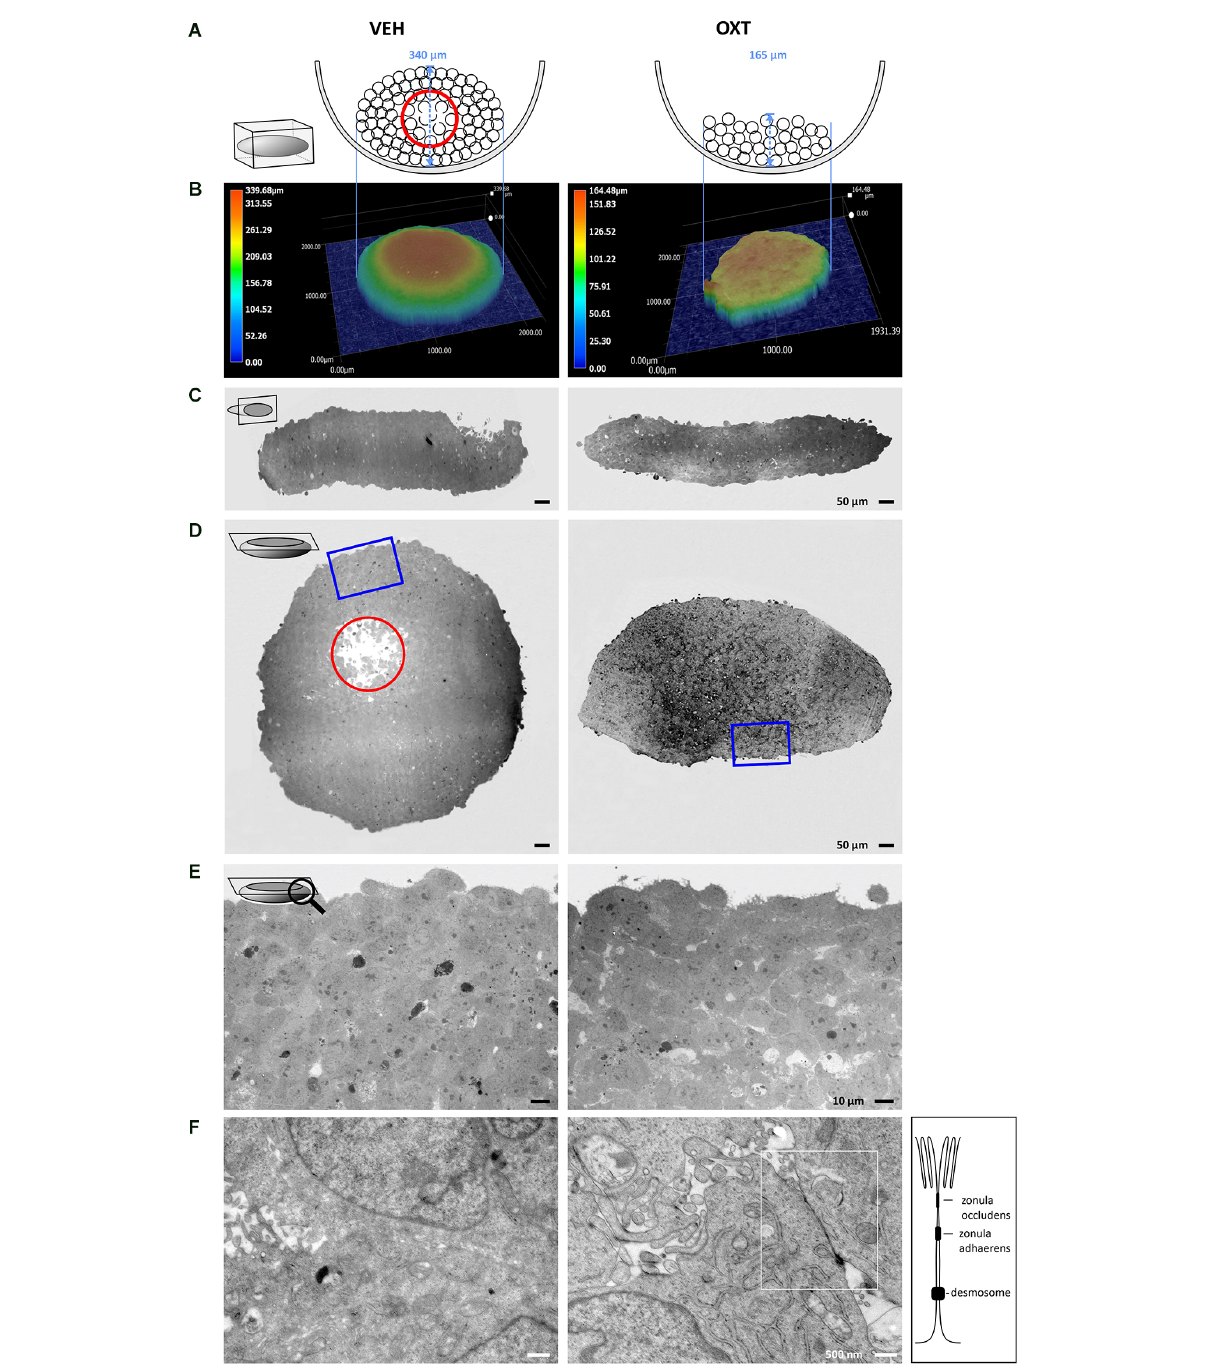
FIGURE4 Images of VEH-treated (left column) vs. OXT-treated (right column, 100 nM for 24 h) spheroids shown in different orientations and magnification using TEM and digital 3D-microscopy. (A) Schematic representation of the OXT-induced effect on spheroid formation. The U-shaped well bottom is shown in the side-view. Black circles represent individual cells, a red circle indicates the apoptotic zone within the round spheroid. Please note the absence of an apoptotic zone in the flat OXT-treated spheroid. (B) Representative 3D images of VEH vs. OXT-treated spheroids. VEH-treated spheroids resemble a gravity-condensed ball-shape, whereas OXT-treated spheroids are irregular in shape and less densely packed. (C) Diagonal 250 × TEM micrographs of 70 nm sections of VEH or OXT-treated spheroids. VEH-treated spheroids appear more uniform, indicating a reduced intercellular space, whereas OXT-treated spheroids show clear intercellular spacing. (D) Longitudinal 250 × micrographs of 70 nm sections of the